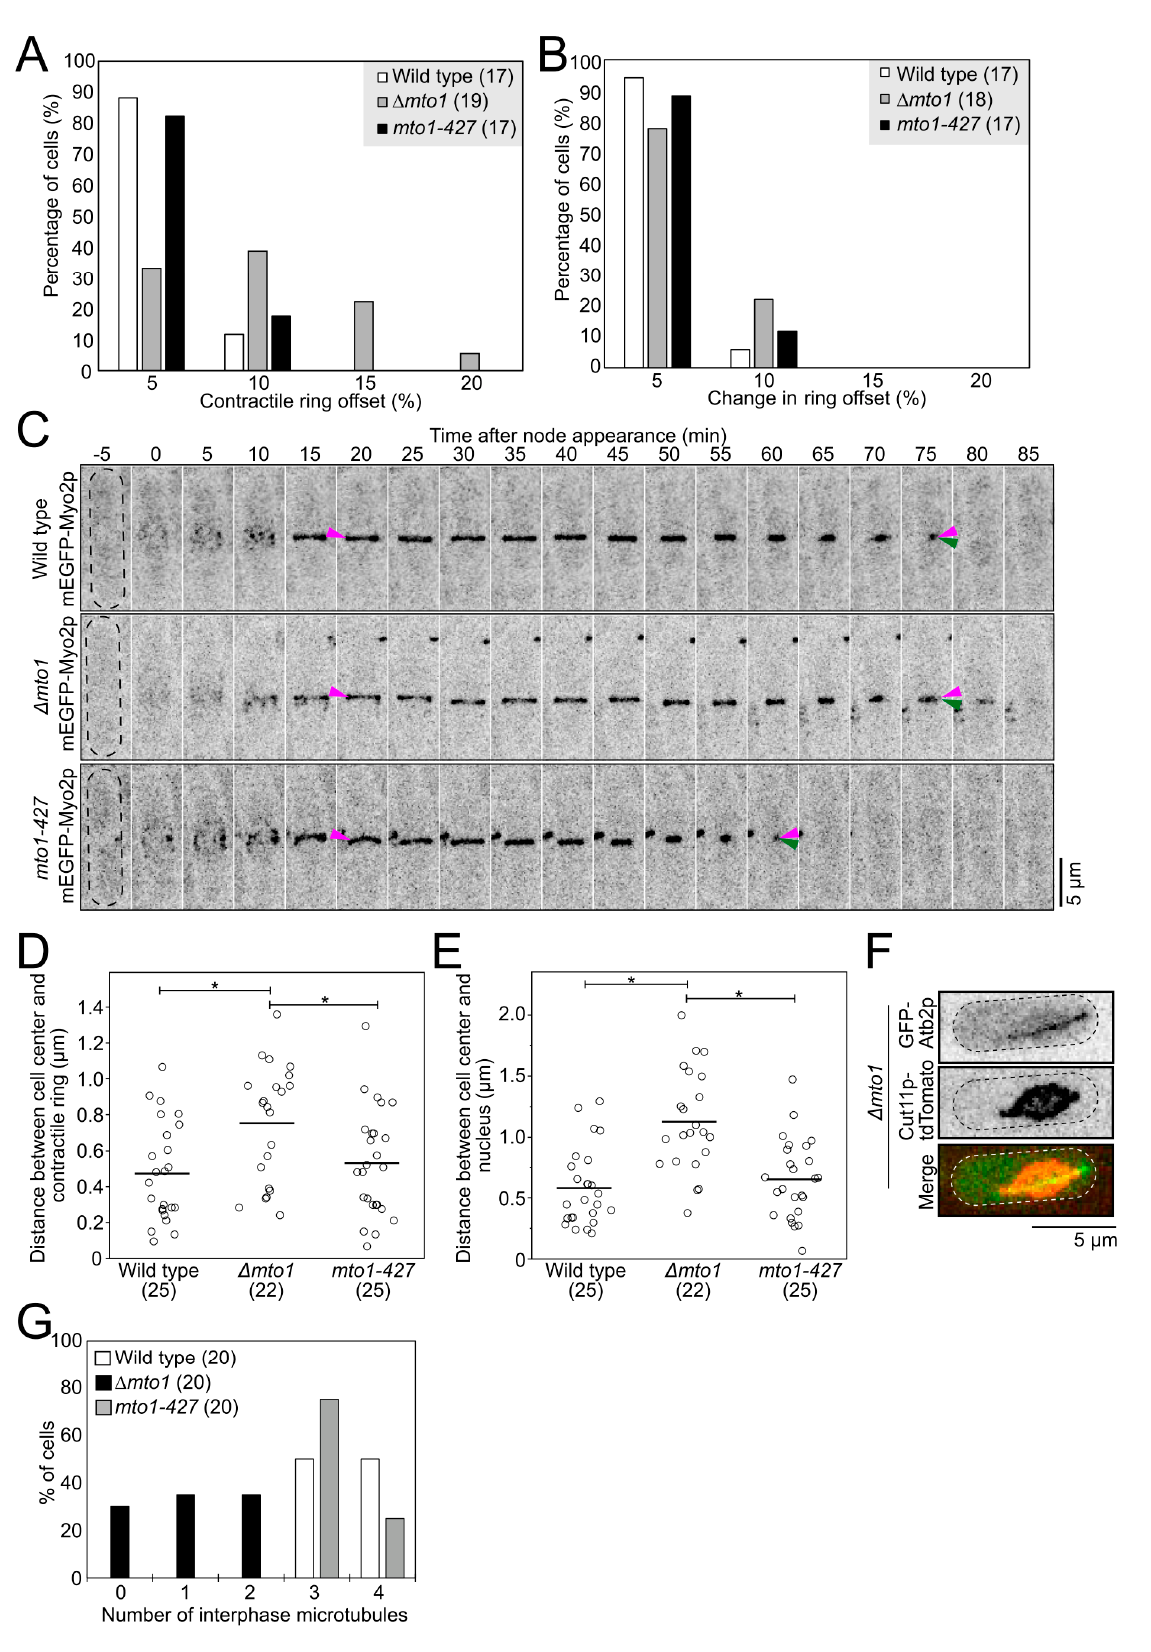
Figure 5. PAA microtubules do not anchor the contractile ring under normal conditions. ( A ), Graph of the ring offset measured at the time of the onset of ring constriction. ( B ), Graph of the change in